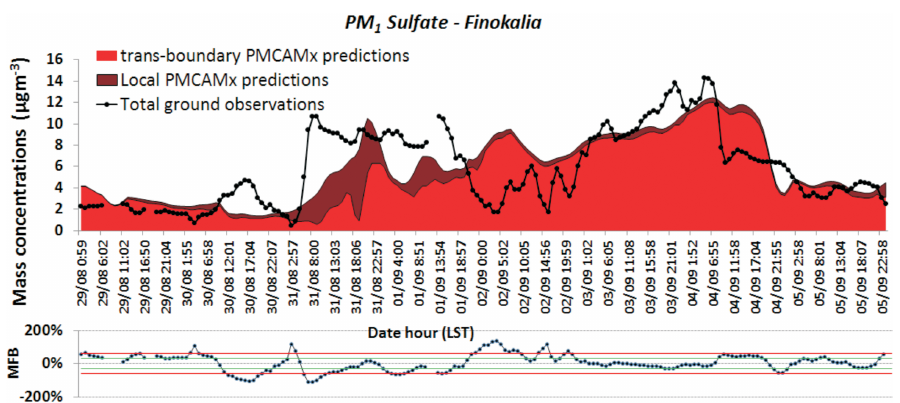
Figure 3. Comparison of PMCAMx (total shaded area) with hourly measurements (black dotted line) of total PM 1 sulfate concentrations (µgm − 3 ) over Finokalia during 31 August–09 September 2011. The contribution of PMCAMx predicted trans-boundary (standard run – scenario 1, in light red) and local (scenario 1, in dark red) to the total PM 1 sulfate mass is also shown. The ability of the model to reproduce observations is estimated through the calculation of the mean fractional biases (MFB), shown at the bottom. Model performance is average (good), when MFB values are within the red (green) lines (Boylan and Russell,